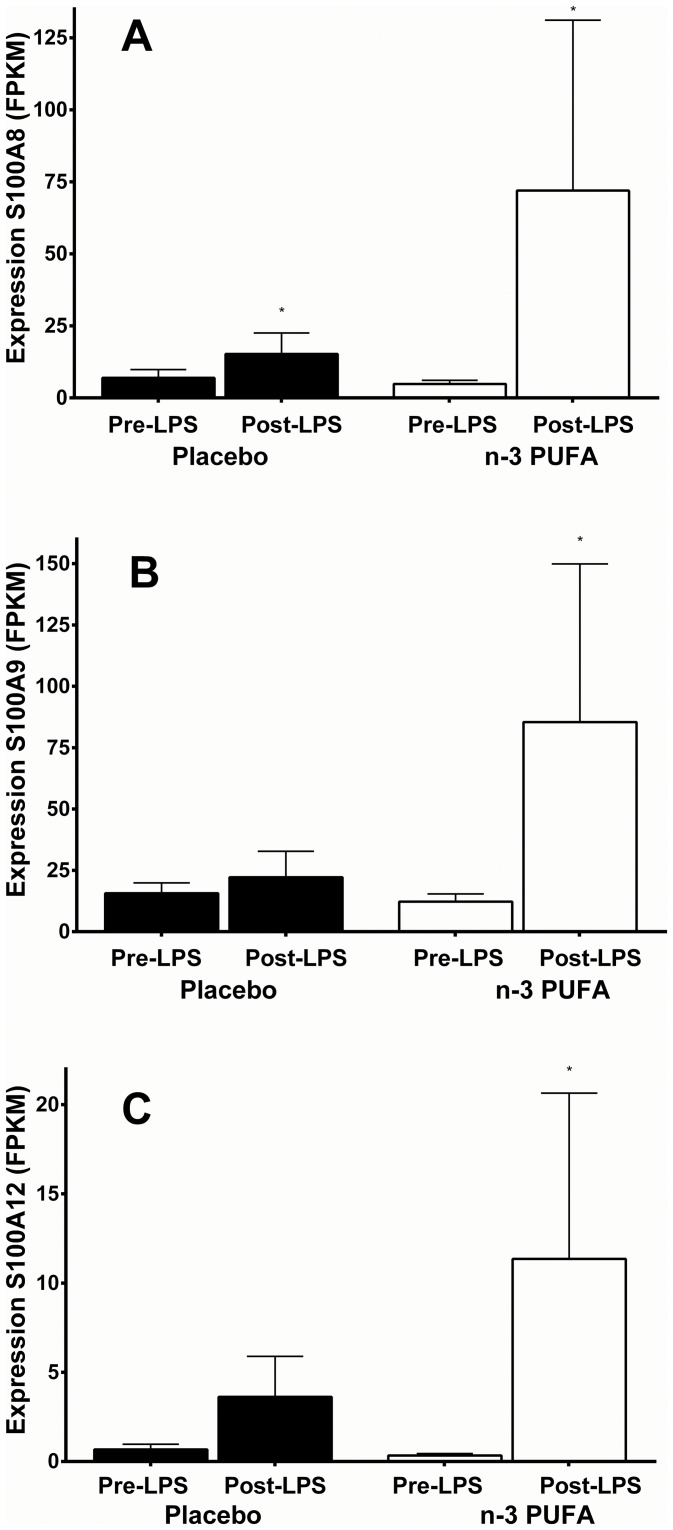
Calgranulin expression S100A8 (A), S100A9 (B) and S100A12 (C) was markedly increased in adipose tissue following n-3 PUFA supplementation and LPS in FFAME Study participants (n = 6 placebo, n = 8 n-3 PUFA).* indicates p<0.01. Data plotted as mean Fragments per kilobase per million fragments mapped (FPKM) and standard error.